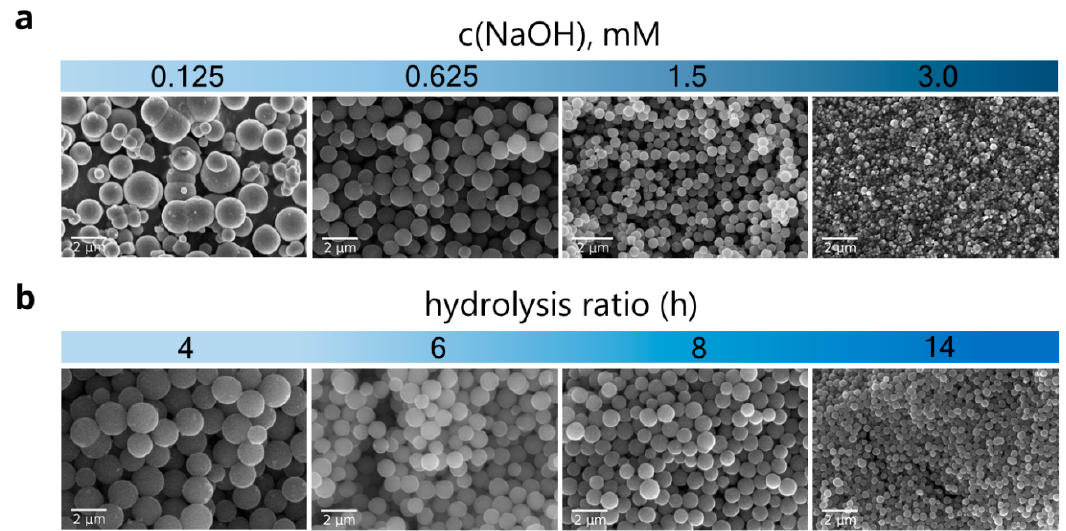
Figure 2. SEM images of the series of the samples that were prepared with varying NaOH concentration and a constant hydrolysis ratio of h = 6 ( a ); the samples prepared with varying hydrolysis ratios and a constant c(NaOH) = 0.625 mM ( b ).